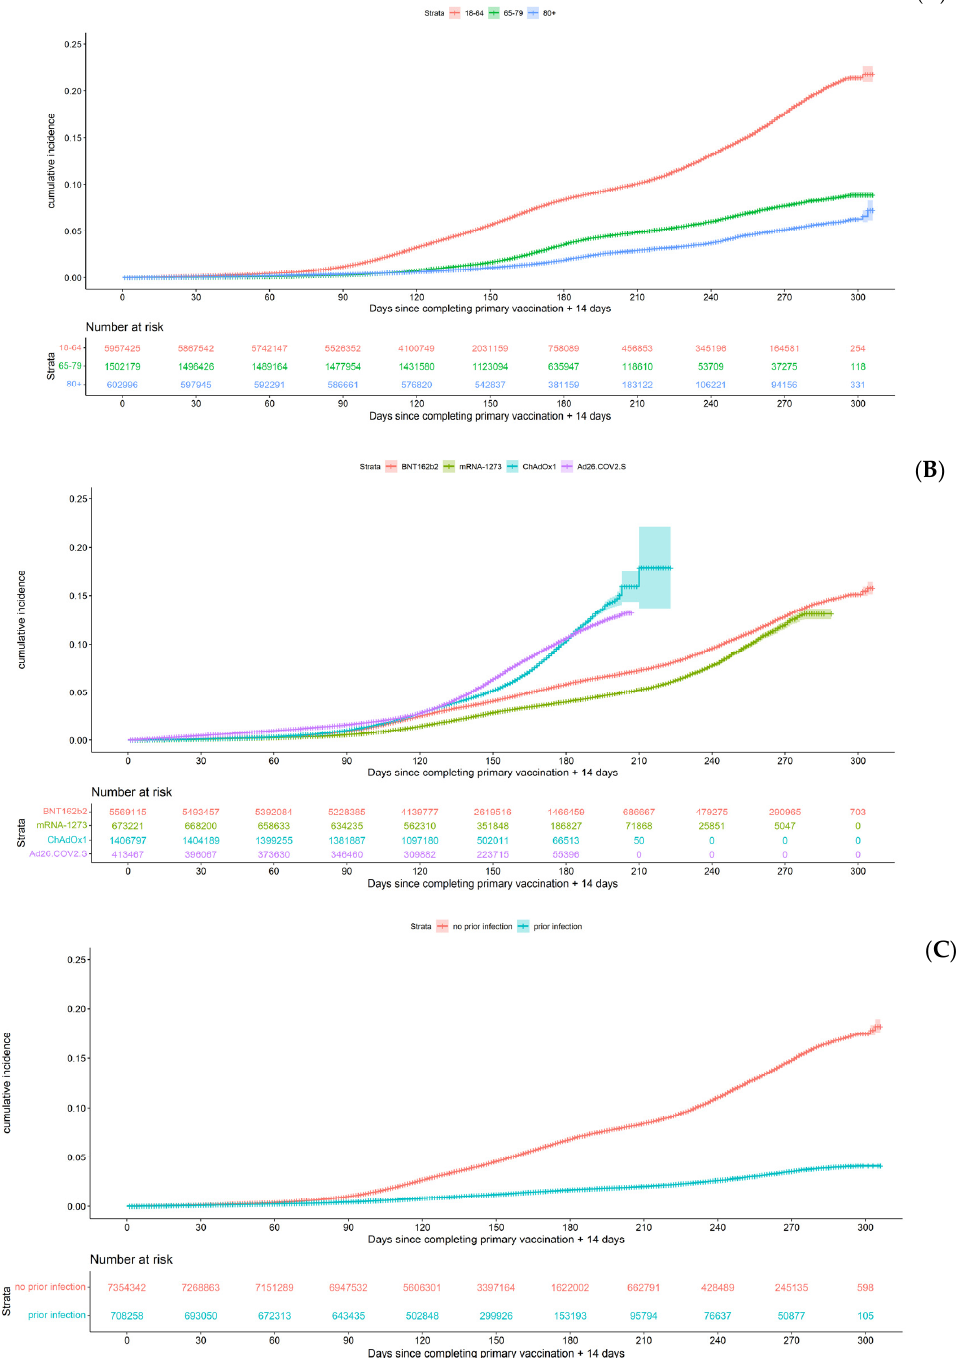
Figure 3. Cumulative incidence of breakthrough infections among fully vaccinated individuals ( A ) by different age groups, ( B ) by brand of primary vaccine and ( C ) by prior COVID-19 infection. Shaded areas represent 95% confidence intervals.